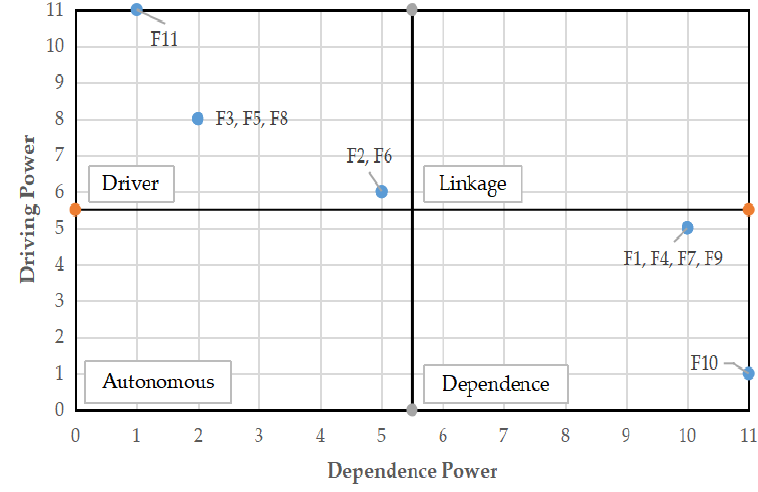
Figure 3. MICMAC